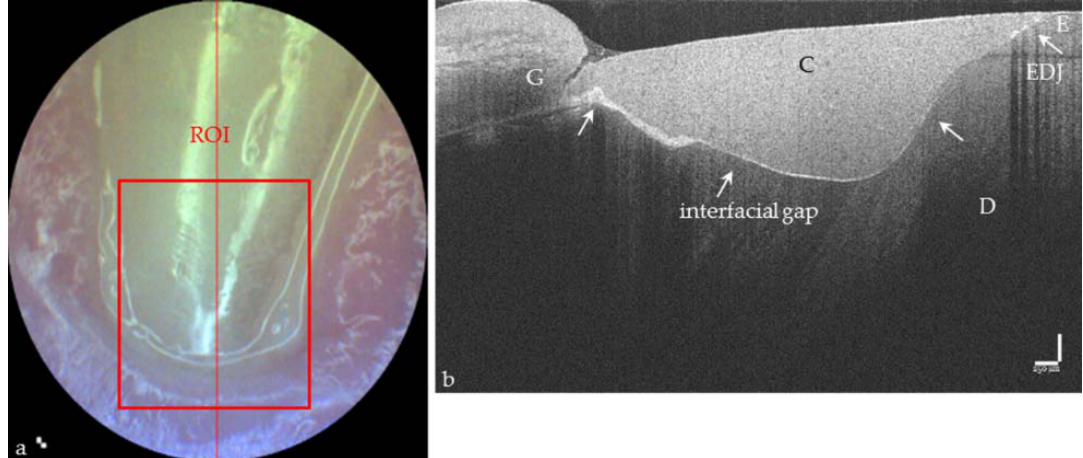
Figure 17. ( a ) Screenshot of the clinical image of a cervical composite restoration (C) on a premolar; ( b ) The cross ‐ sectional OCT image reveals a homogeneous filling showing an extended bond failure at the dentin and enamel (bright signal lines, white arrows). At enamel margin (E), no gap appears, whereas the gingival margin (G) shows a gap which is extended along the composite ‐ dentin interface. In multiple equidistantly distributed cross ‐ sectional images, the length of the interfacial adhesive failures can be measured for dentin (D) and enamel (E). From these, the “percentage gap” of this restoration can be derived separately for enamel and dentin. EDJ: enamel ‐ dentin junction.